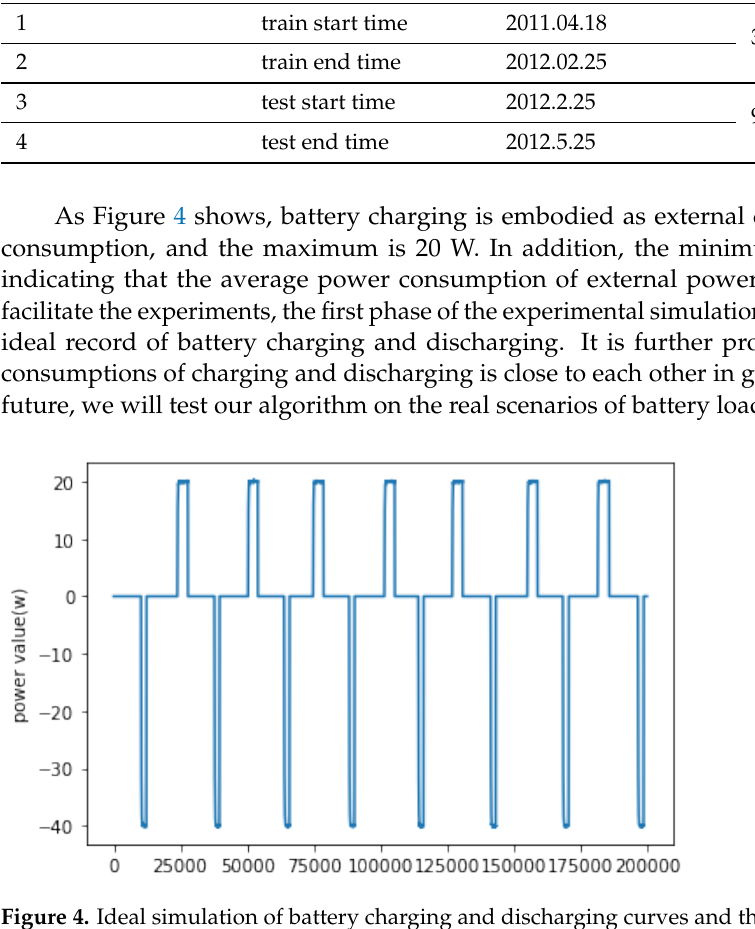
Figure 4. Ideal simulation of battery charging and discharging curves and their data